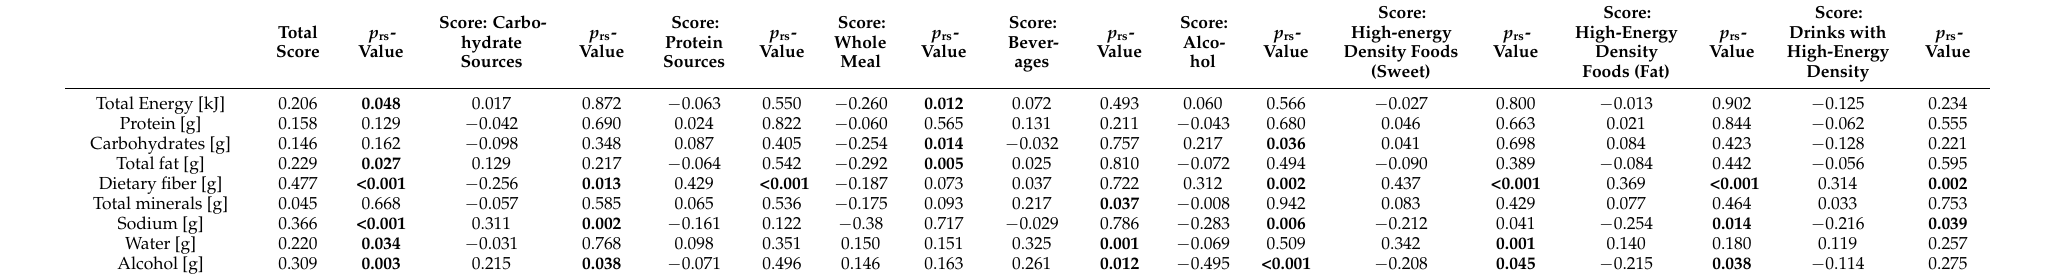
Table 4. Indications of relative validity: Nutrient intake of three-day food record in correlation to selected HEI-flex